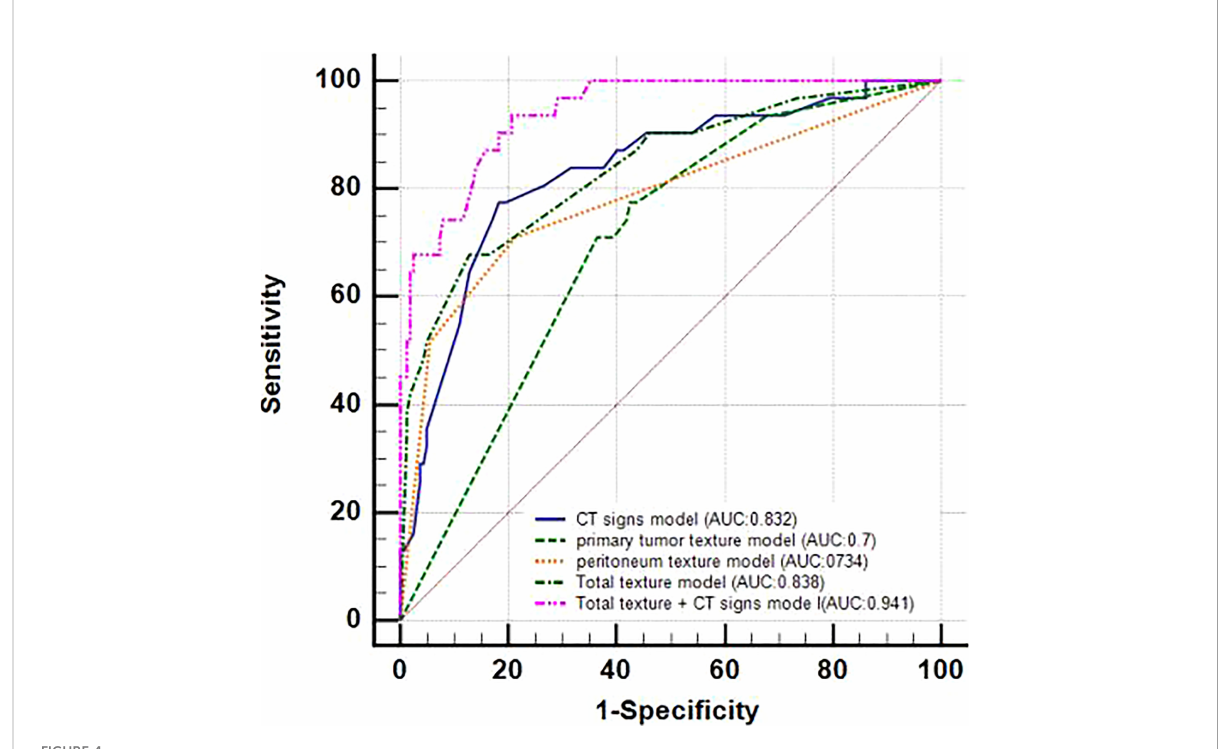
FIGURE 4 ROC curves of 5 different prediction